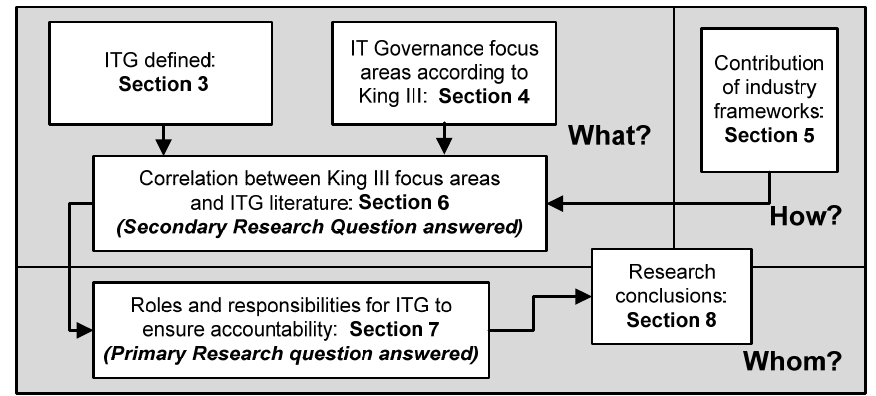
Figure 1: Research